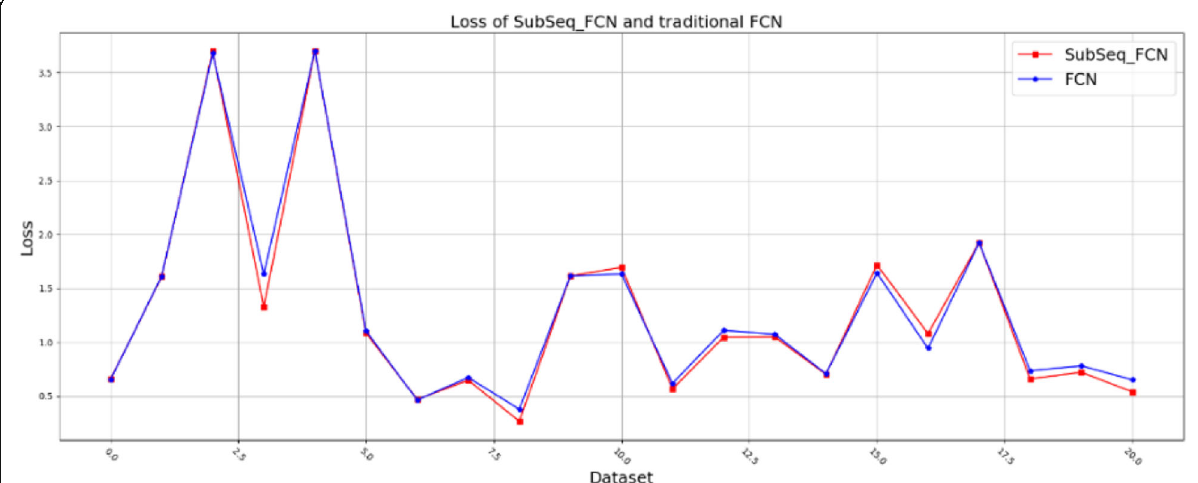
Fig. 16 Loss of SubSeq_FCN and traditional